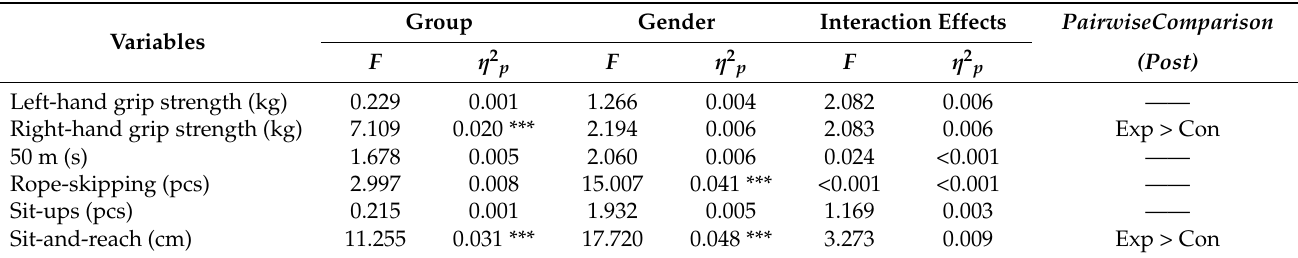
Table 6. Analysis of covariance results for the physical fitness test indexes between the experimental and control